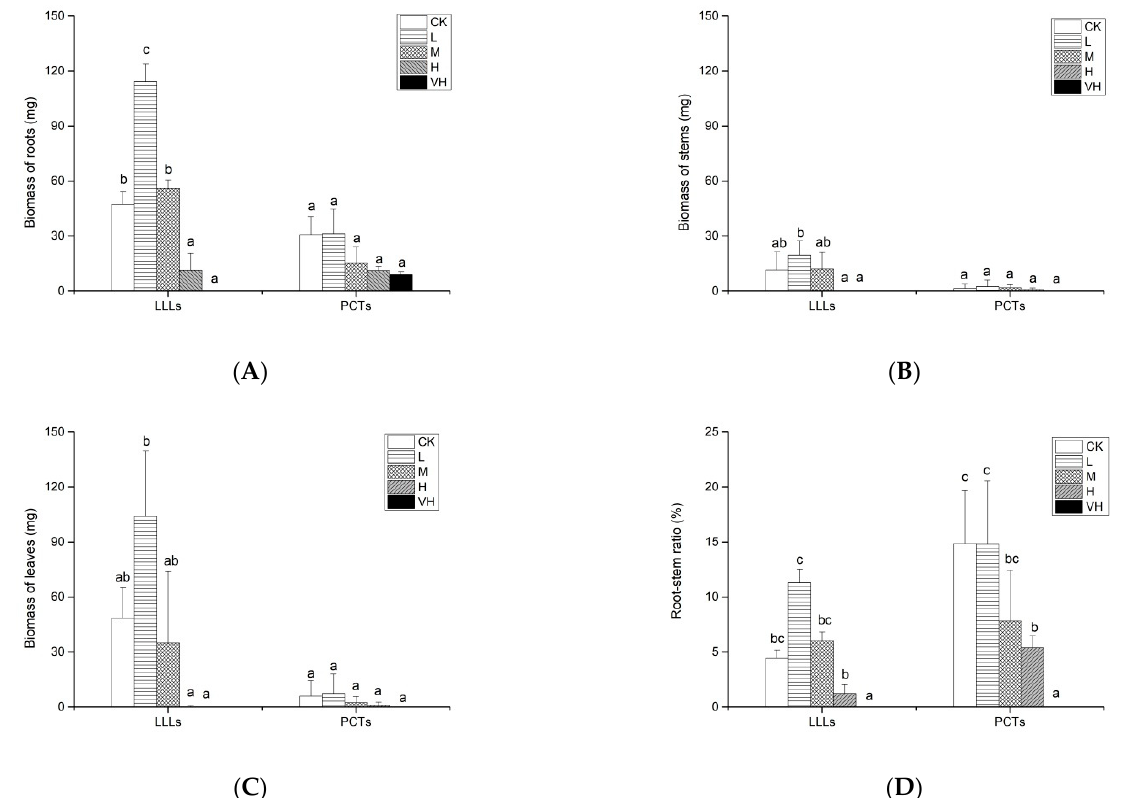
Figure 4. Effects of LLLs and PCTs from K. obovata on biomasses of A. corniculatum roots, stems, and leaves, as well as the root–stem ratios. Young A. corniculatum propagules were exposed to 0 (CK), 2 (L), 10 (M), 20 (H), and 50 (VH) g L − 1 of leaf litter leachates and 0 (CK), 10 (L), 100 (M), 200 (H), and 600 (VH) mg L − 1 of purified condensed tannins based on 10 ppt artificial sea water for 3 months, respectively. Next, the A. corniculatum biomasses of roots, stems, and leaves ( A – C ) and the root–shoot ratios ( D ) were evaluated and compared between the LLLs and PCTs of K. obovata treatments. Single letters (a, b, and c) represent significant differences among groups ( p < 0.05). Double letter ab denotes no significant difference with a or b. Each column ( ± SD) represents the mean of three individual A. corniculatum